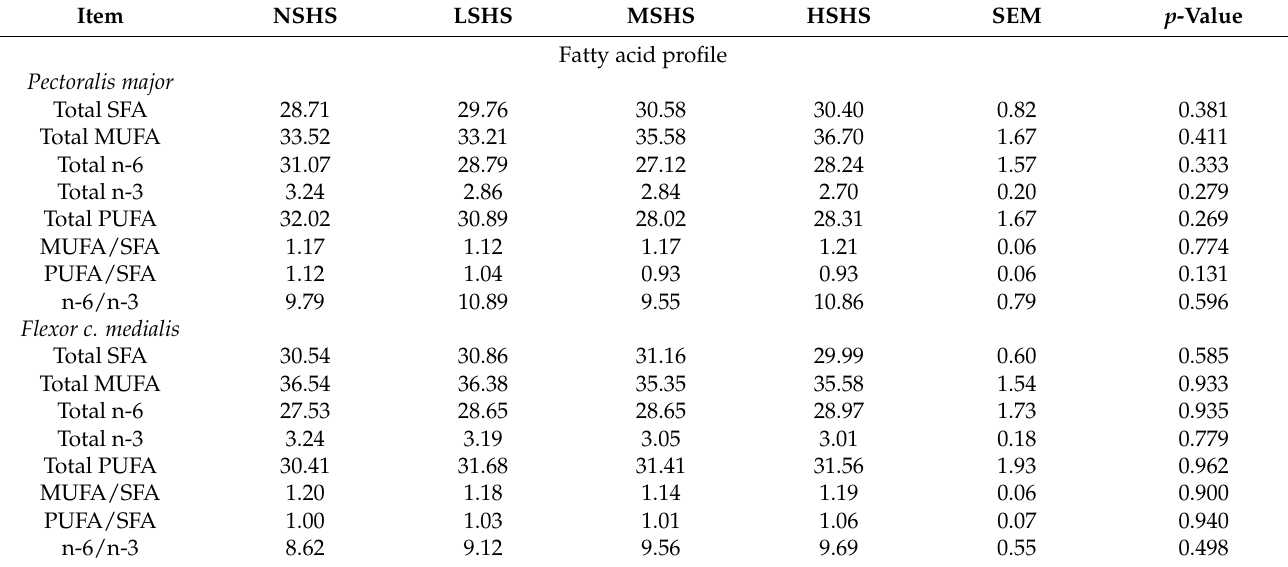
Table 3. Effects of the level of electrical stunning, halal neck cutting, and subsequent bleeding on the Pectoralis major and Flexor cruris medialis fatty acid profile (g/100 g of meat) in broiler